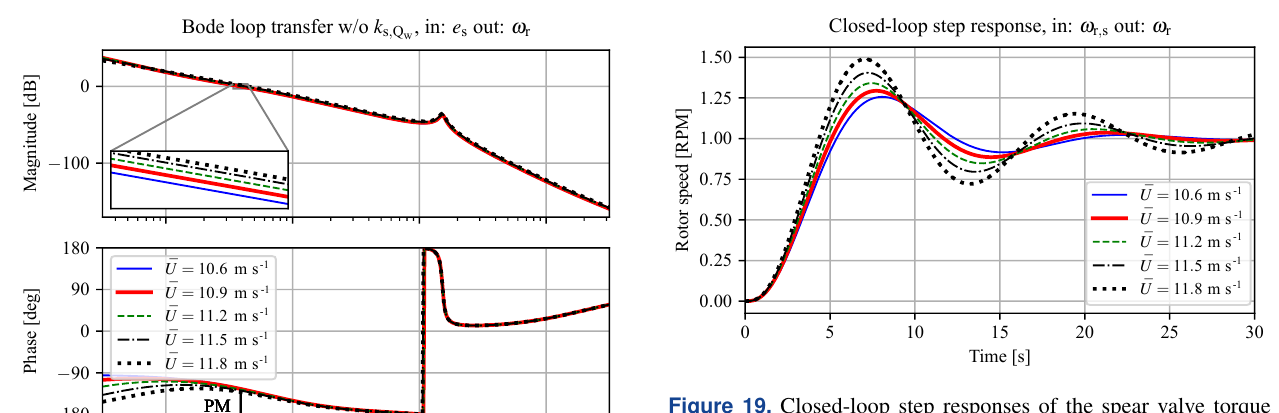
Figure 19. Closed-loop step responses of the spear valve torque control implementation. It is shown that the feedback loop is sta- bilized, but that the dynamics vary with increasing wind speeds. A control implementation that takes care of the varying spear valve Figure 17. Bode plot of open-loop transfer, including controller position pressure gradient would load to a more consistent from spear valve position reference to the rotor speed, without spear valve pressure feedback gain k s ,Q . The phase margin (PM) at mag- w nitude crossover is indicated.